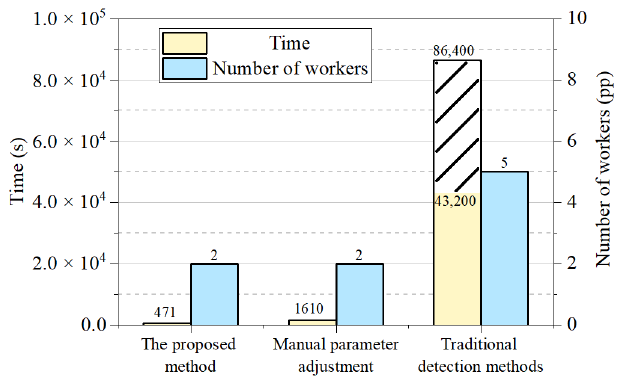
Figure 15. Comparison of detection efficiency of a one-kilometer tunnel: the first column is the use of the tunnel inspection vehicle and the proposed parameter calculation method, the second column is the use of tunnel detection vehicles and manual adjustment of parameters, and the third column is the traditional manual detection method.